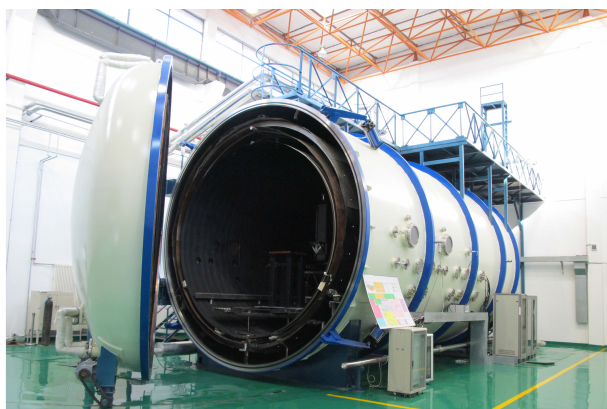
Figure 3. Plume effect test system (PES) of Beihang University.